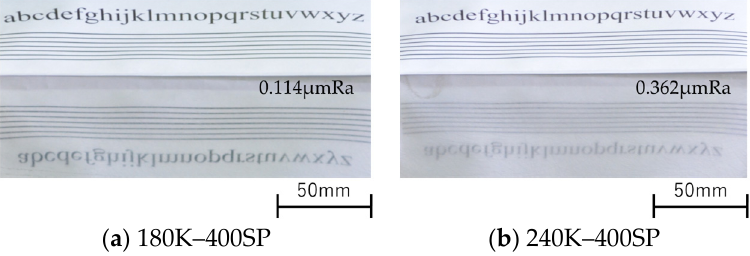
Figure 15. Surface condition and surface roughness when grinding with the 180K–400SP and 240K–400SP combinations.